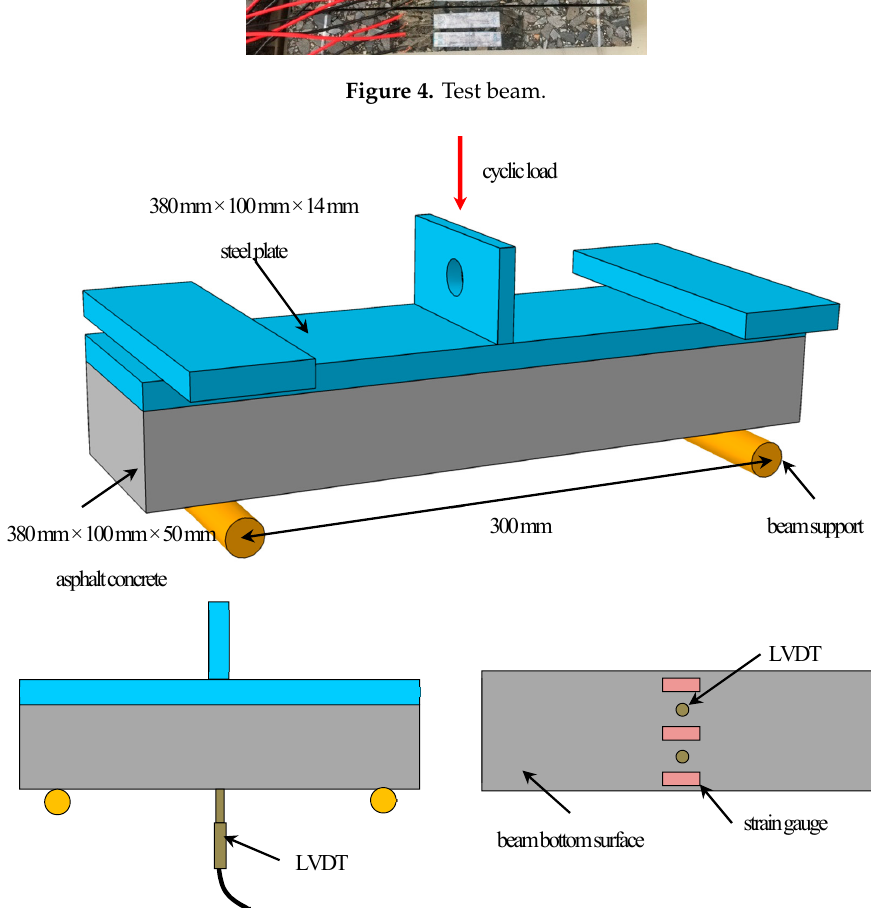
Figure 5. Schematic illustration of the fatigue test for asphalt concrete beam. (LVDT: linear variable differential transducer.).